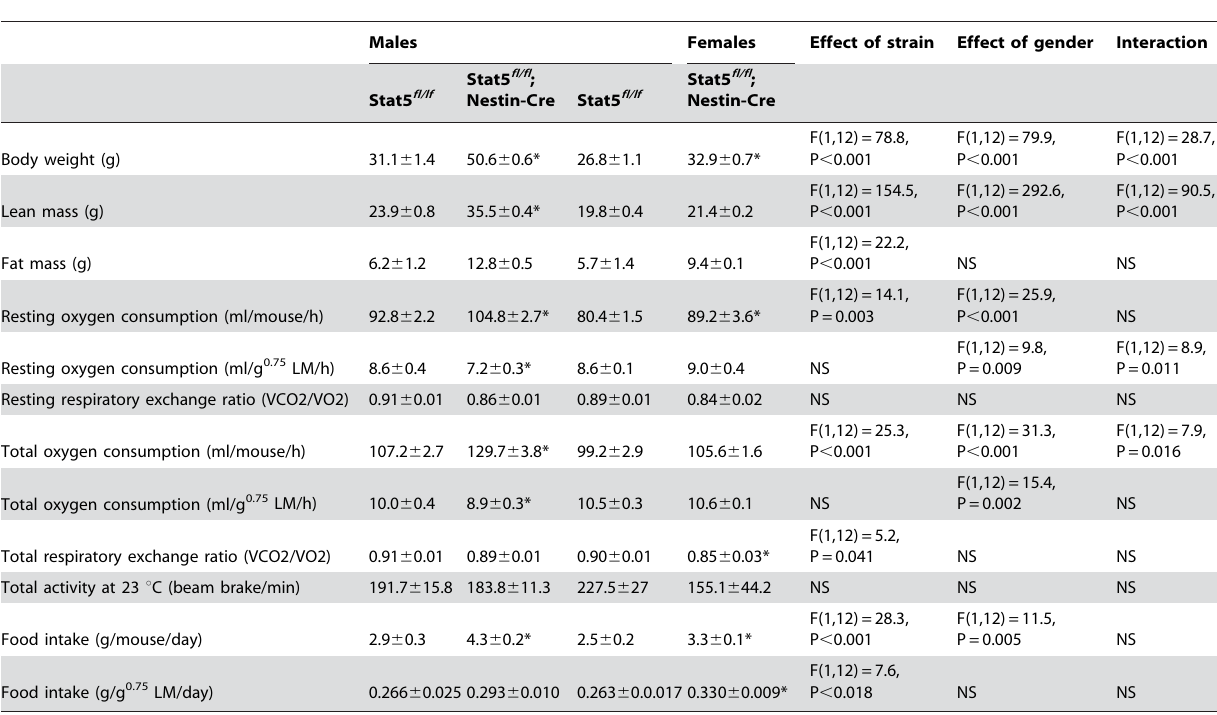
Table 2. Metabolic parameters of Stat5 fl/fl and Stat5 fl/fl ; Nestin-Cre mice